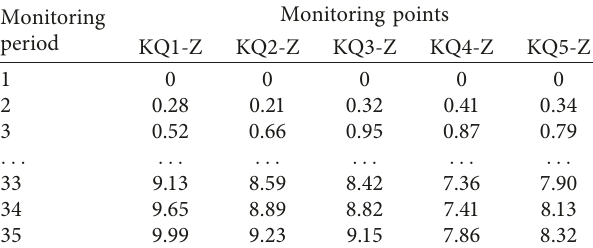
Table 3: Subsidence monitoring data (mm).